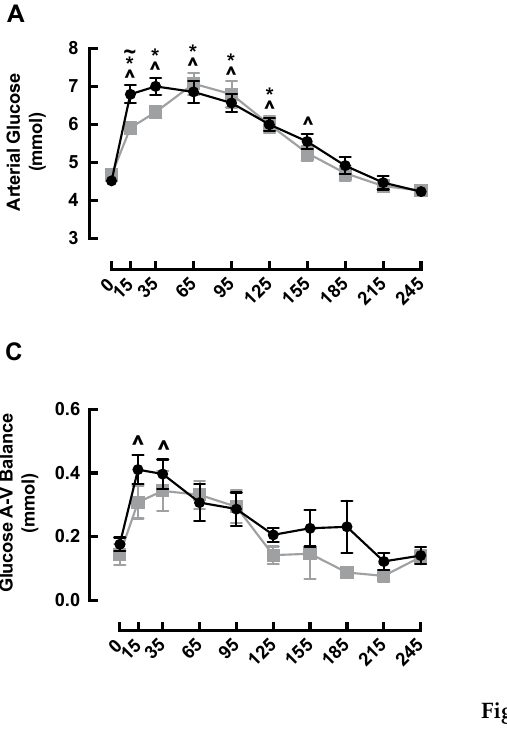
Figure 4. Changes in arterial glucose ( A ), venous glucose ( B ), glucose A-V balance ( C ), glucose uptake ( D ), insulin ( E ) and insulin AUC ( F ) in healthy older adults in response to cocoa or control, following oral nutritional supplement feeding. ~ denotes a significant difference between conditions ( p < 0.05); ^ denotes significant difference from control baseline ( p < 0.05); * denotes significant difference from cocoa baseline ( p < 0.05). AUC, area under the curve; A-V, arterio-venous. 4. Discussion We investigated if acute cocoa flavanol supplementation coupled to oral feeding would modify micro- and macrovascular responses in the leg, and subsequent metabolic responses, in healthy older adults. We found that acute supplementation of cocoa fla- vanols increased micro- but not macrovascular responses to ONS; these microvascular changes did not translate into improved glucose/insulin responses. Our primary finding was that acute cocoa flavanol supplementation may overcome age-related vascular dysfunction in the postprandial state (in the context of the m. vastus lateralis ), suggesting that the impact of cocoa flavanols goes beyond the effect of the feed- ing-related insulin response, which alone is known to enhance microvascular flow [34]. As enhanced MBV is observed following acute cocoa supplementation, and since we have found plasma epicatechin to peak 2 h following cocoa flavanol consumption (baseline: none detected, 2 h: 0.21 ± 0.06 µM, undetectable following placebo), it is likely that in-